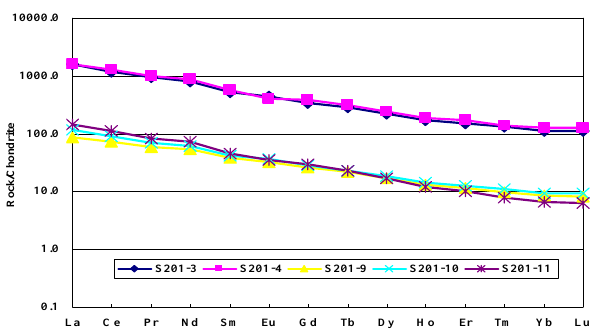
Fig. 4 . Discrimination Nb-Zr-Y diagram (Meschede, 1986) for basalts from the four segments. (AI, AII = fields of intraplate alkali basalts; AII, C = fields of intraplate tholeiites; B = field of P- field of N-type MORB; C, D = fields of volcanic arc basalts.)